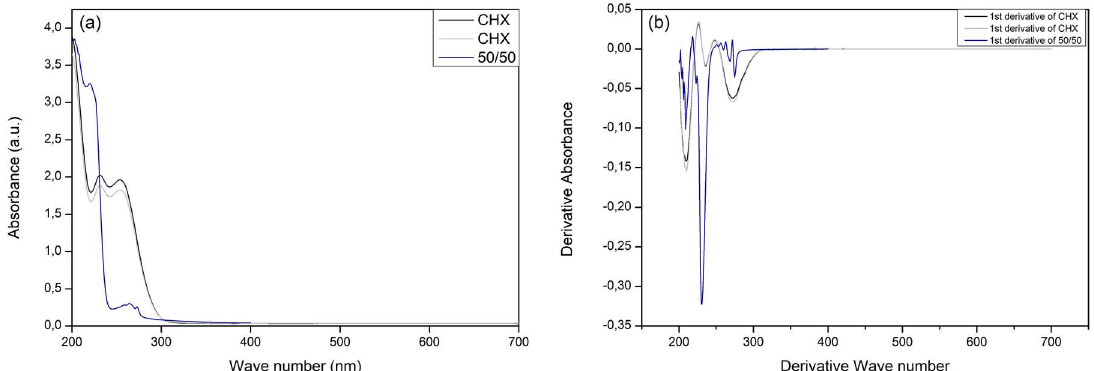
Figure 5. (a) UV spectra of CHX and release medium of sample 50/50 and (b) respective